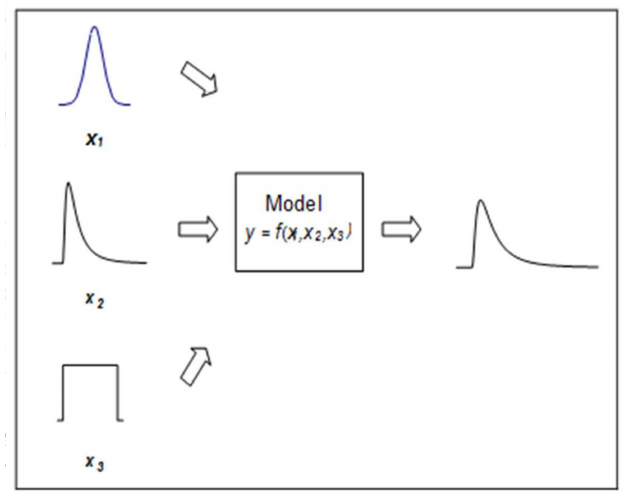
Figure 2. Monte Carlo simulation is an iterative process where each trial requires a new set of inputs which are random samples from probability distributions. After the simulation has been halted, the output of the model is represented by a probability distribution from which the mean, median and confidence intervals can be